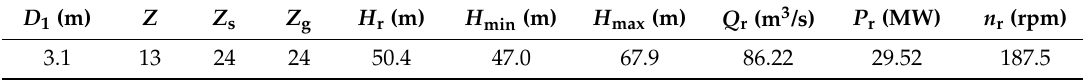
Figure 3. Performance curves measured in model test of runner HLA551. Table 1. Design parameters of the Francis turbine runner.